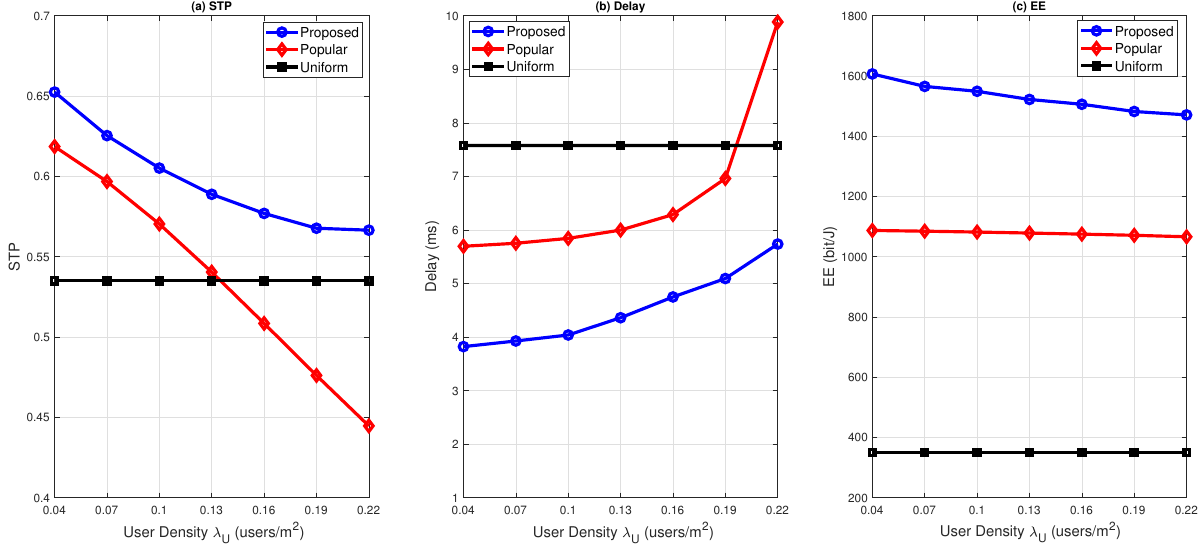
Figure 7. STP, delay, and EE versus user density when M = 20 contents, λ F = 0.01 F-APs/m 2 , λ C = 0.0001 C-APs/m 2 , R = 150 m, γ = 0.8, α = 4, P F = 30 dBm, P C = 40 dBm, P s = 37 dBm, ρ = 15.13, W F = 100 MHz, W C = 500 MHz, T = 1 ms, and τ = 0.1 Mbps.